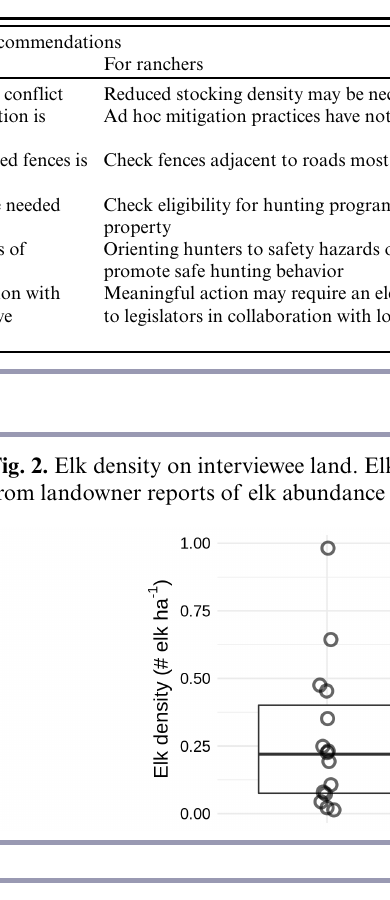
Table 1. Key findings and management implications